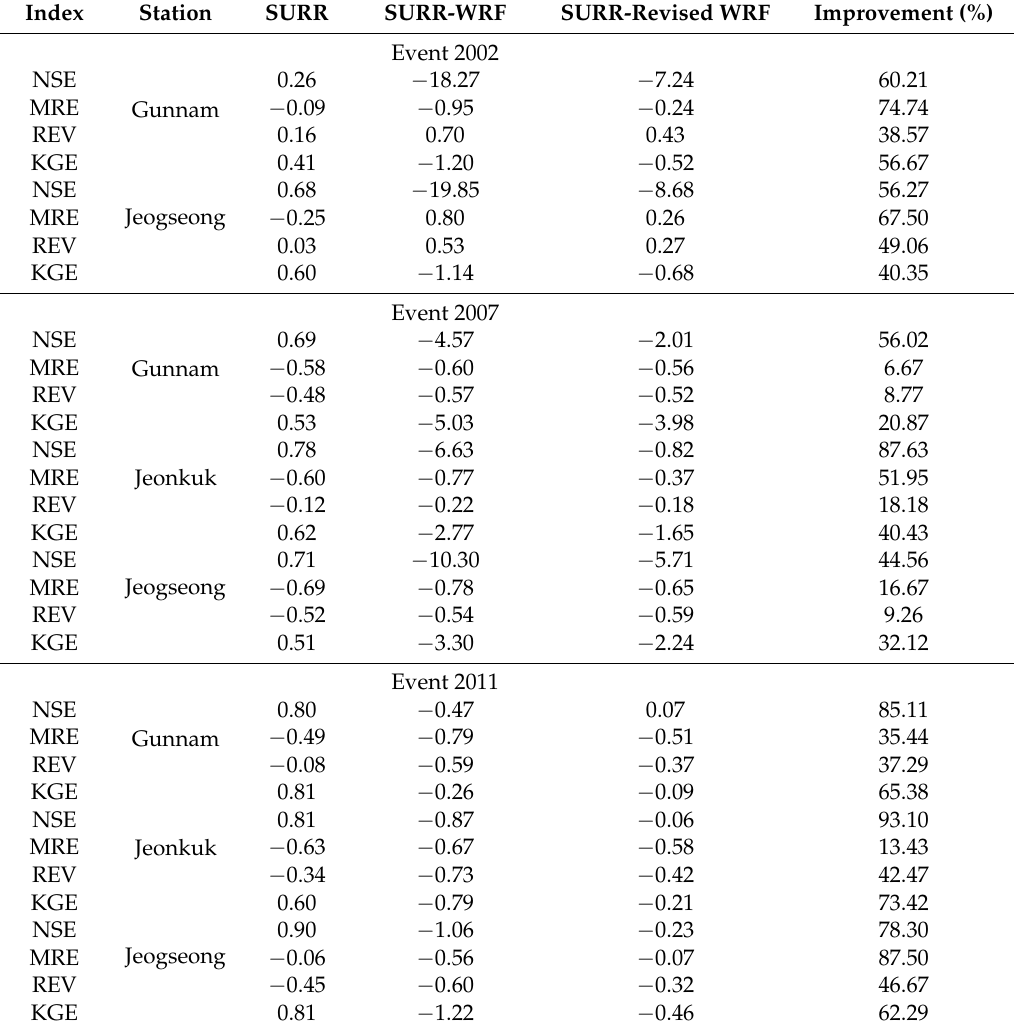
Table 5. Comparison of results for the statistical error measurement for the 2002, 2007 and 2011